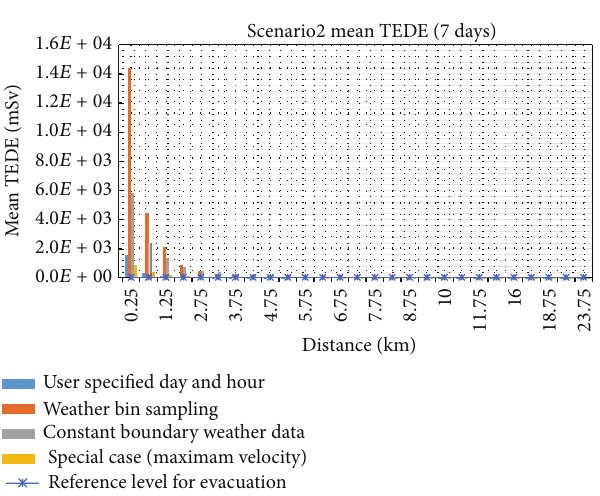
Figure 5: Scenario 2 mean TEDE (7 days).